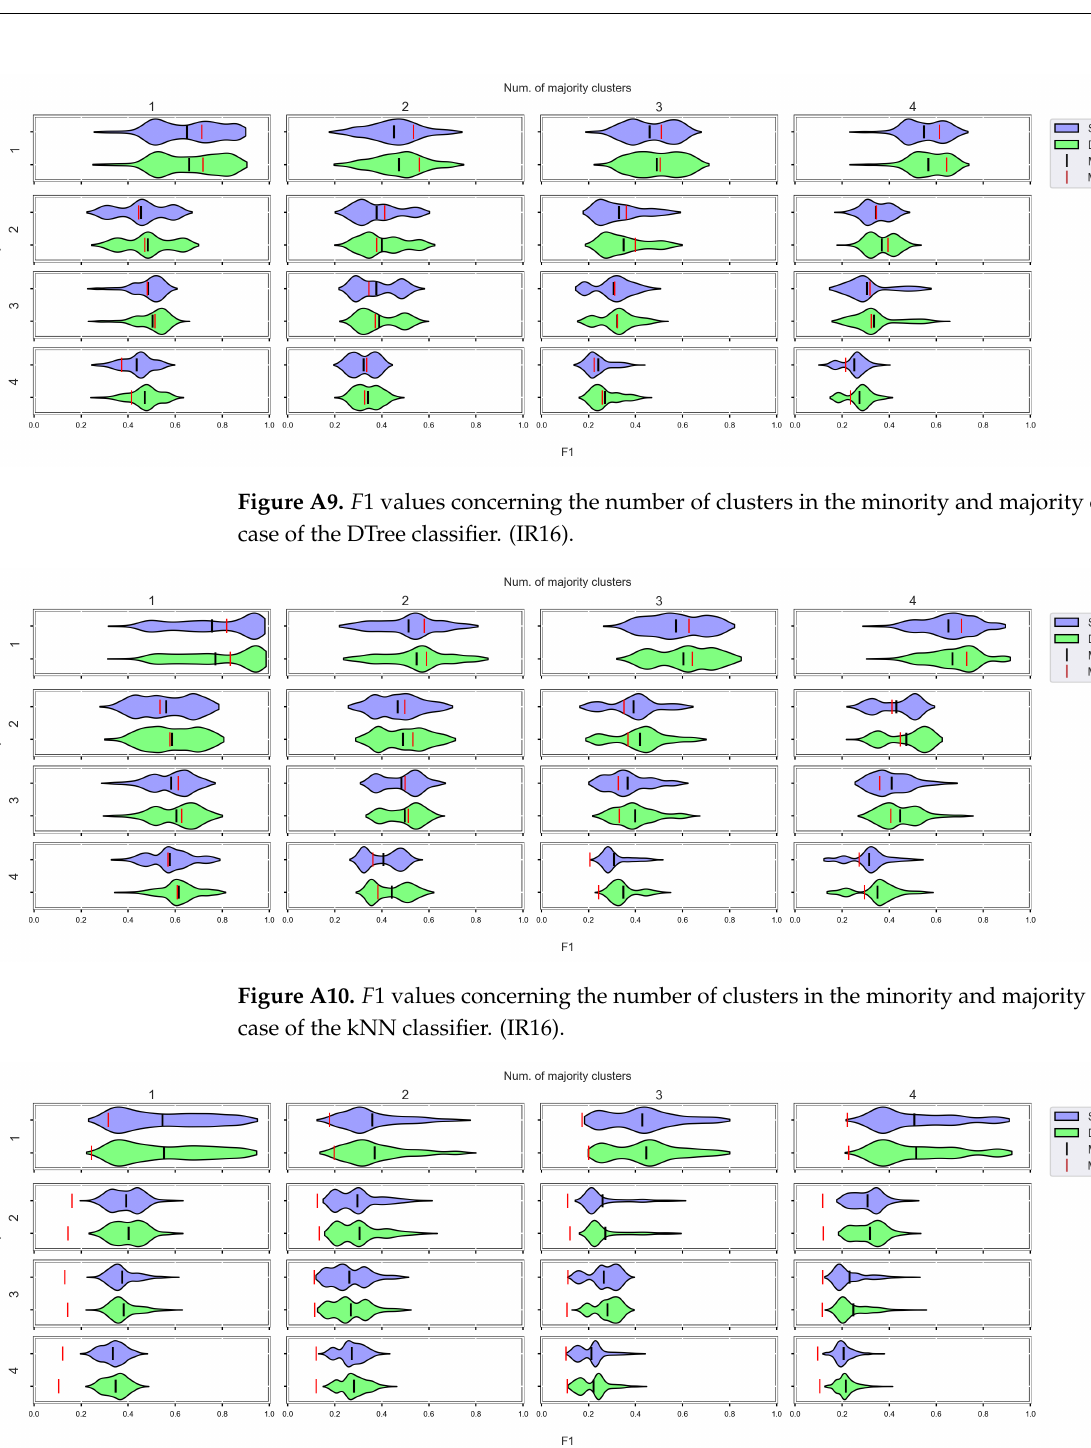
Figure A11. F 1 values concerning the number of clusters in the minority and majority classes in the case of the MLP classifier.